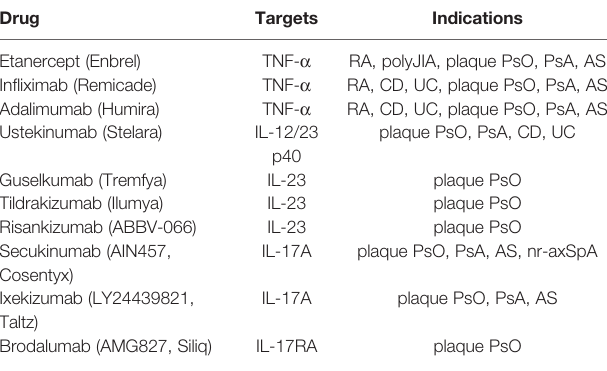
TABLE 2 | Anti-TNF- a , IL-12/23 p40, IL-23, IL-17A and IL-17RA agents approved by